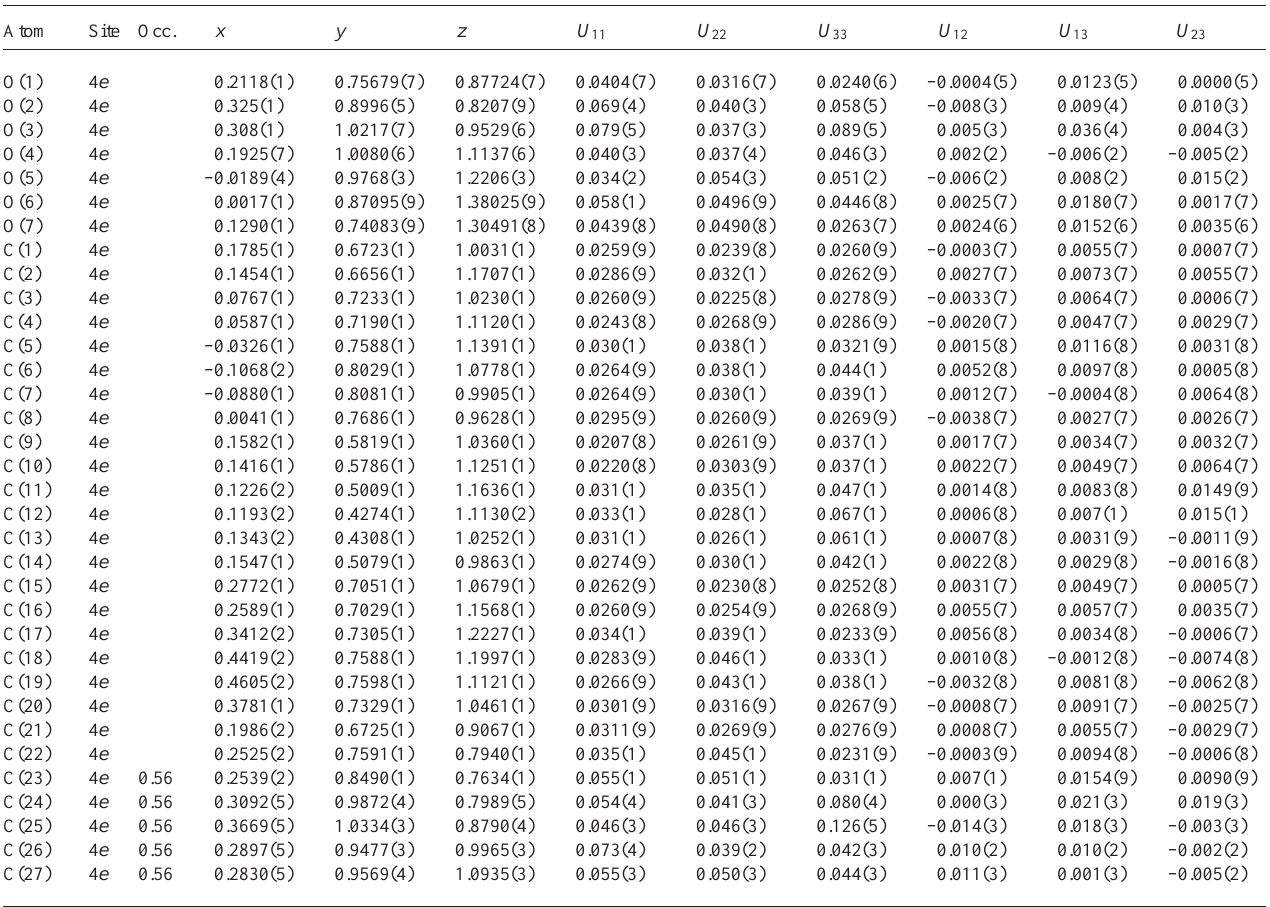
Table 3. Atomic coordinates and displacement parameters (in Å 2 ) .